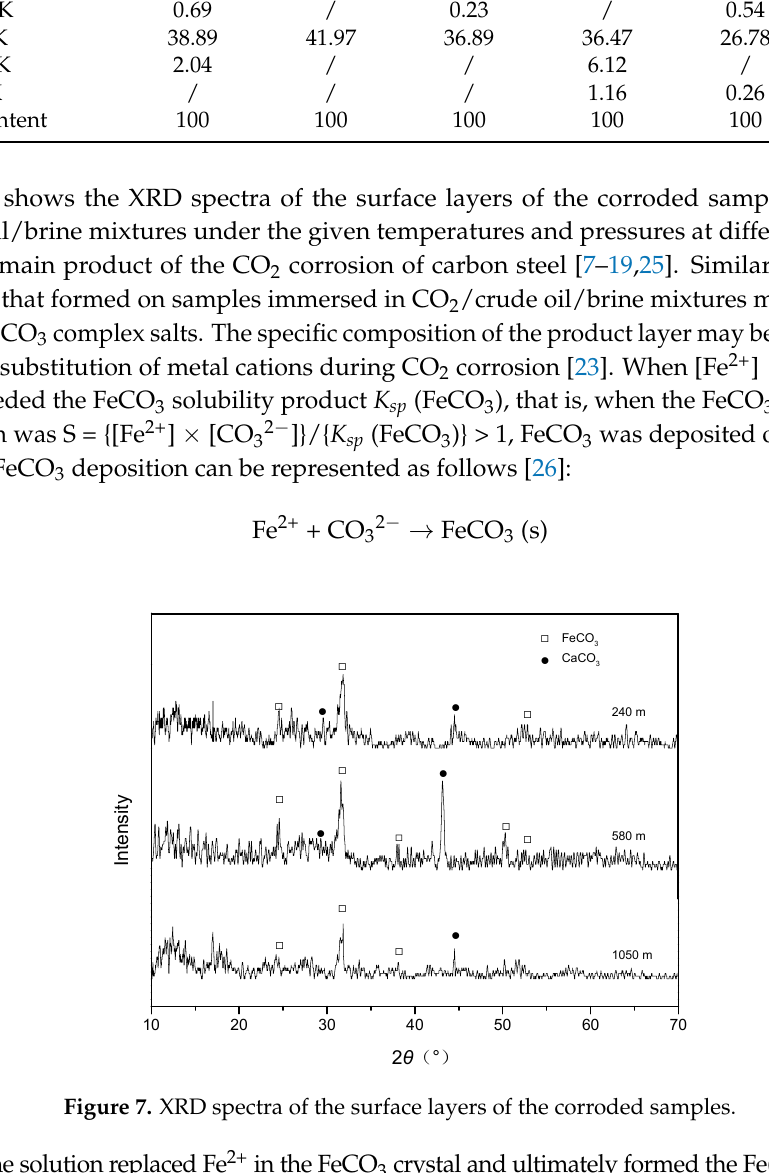
Table 4. EDS results for the surfaces of J55 steel after corrosion (%).